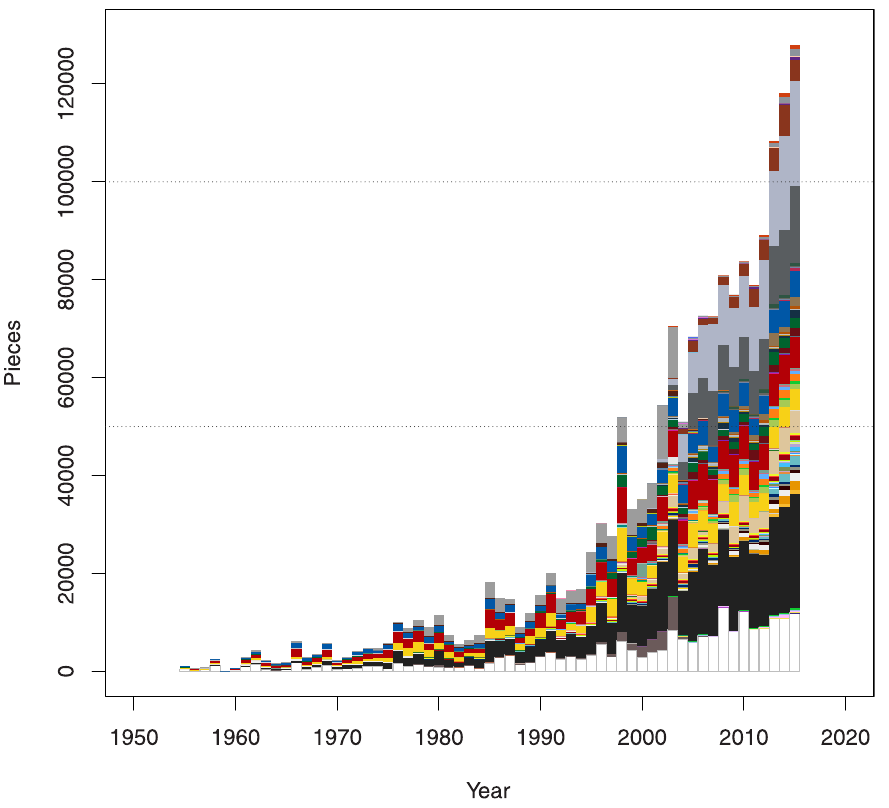
Fig 5. Frequencies of brick colors across time. The x-axis indicates